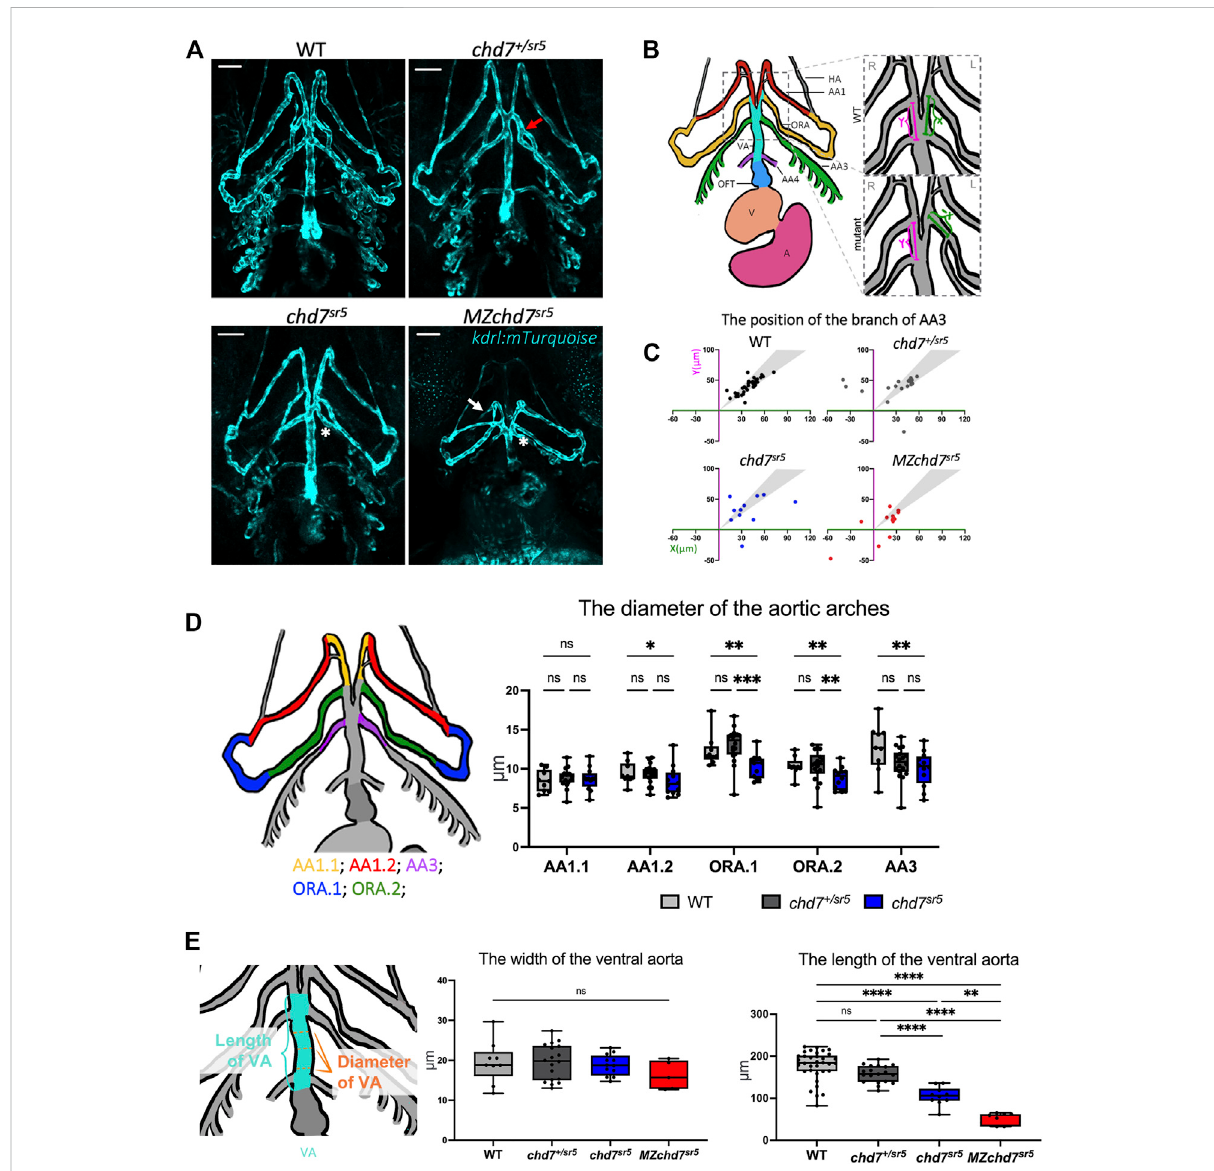
FIGURE 4 chd7 sr5 mutants show defects in arch artery patterning and ventral aorta length. (A) Ventral view of the kdrl:mTurquois fi sh at 102 hpf. 20x stacked confocal image, number of stacks: WT n = 25 (interval = 5 µm), chd7 sr5/+ n = 17 (interval = 7.5 µm), chd7 sr5 n = 20 (interval = 7.5 µm), and MZchd7 sr5 n = 21 (interval = 7.5 µm). Scale bar = 50 µm. (B) Schematic of ventral view of the zebra fi sh vasculature system at 102 hpf. The enlarged/ zoomed in schematic illustrated the abnormal AA3 branching observed in some of the chd7 mutants. The distance between the branching points of the ORA and AA3 along the VA was measured. X = the length on the left side of the fi sh, Y = the length on the right side of the fi sh. If the AA3 branches off from the ORA instead of the VA, a negative value is used to quantify the length. AA, aortic arch; AA1, mandibular arch; ORA, opercular artery; AA3, fi rst branchial arch; AA4, second branchial arch; HA, hypobranchial artery; VA, ventral aorta; OFT, out fl ow tract; V, ventricle; andA,atrium. (C) Quanti fi cationofthebranchingpositionsoftheAA3ontheleftandrightsideofWT, chd7 sr5 ,and MZchd7 sr5 as X and Y coordinates. Each spot in the scatter diagram indicates one single fi sh. The gray area represents the range of symmetric distributions, in which the differences of the distance between X and Y is less than 15%. (WT: n = 34, chd 7 +/sr5 : n = 19 , chd7 sr5 : n = 11 , and MZchd7 sr5 : n = 14). (D) Schematic and data quanti fi cation of the diameter of the AA1, ORA, and AA3. Due to the variation in the diameter at different segments of the vessels, AA1 and ORA were separated into AA1.1 and AA1.2 and ORA.1 and ORA.2, respectively. (WT: n = 9, chd 7 +/sr5 : n = 18 , and chd7 sr5 : n = 12). The statistical analysis was performed using the two-way ANOVA test (mixed-effects analysis). (E) Schematic and data quanti fi cation of the width and length of the OFT. The mean diameter of the VA was used for quanti fi cation. The statistical analysis was performed using the ordinary one-way ANOVA test. (WT: n = 34, chd 7 +/sr5 : n = 19 , chd7 sr5 : n = 11 , and MZchd7 sr5 : n = 14). ns: p ≥ 0.05, *: p < 0.05, **: p < 0.01, ***: p < 0.001, ****: p <